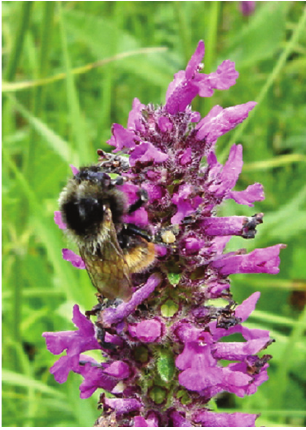
Figure 9: B. pomorum worker foraging from Betonica o ffi